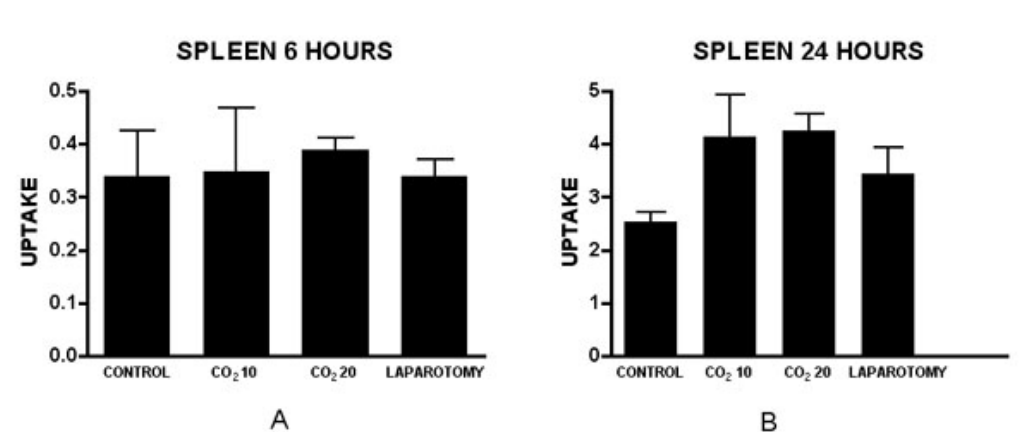
FIGURE 3 - Technetium-99m uptake in the liver after six hours (A) and 24 hours (B). Each bar represents the mean ± SEM of six animals. * p <0.01 vs